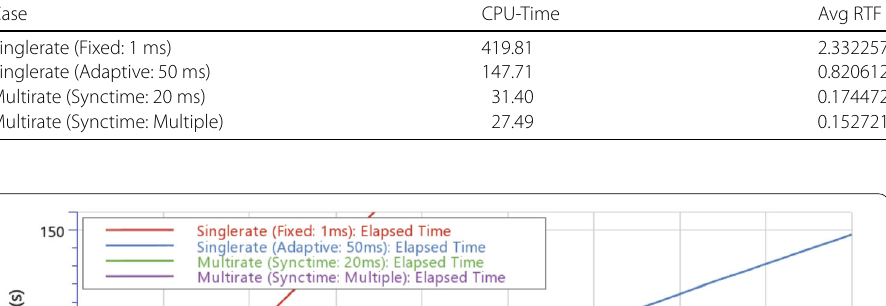
Table 1 Comparison of singlerate and multirate approaches corresponding CPU-time and average real time factor (RTF) for BEV with cooling system simulation Case